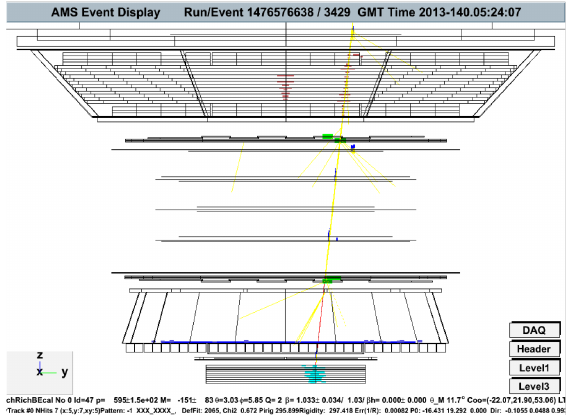
Figure 2. Example of simulated